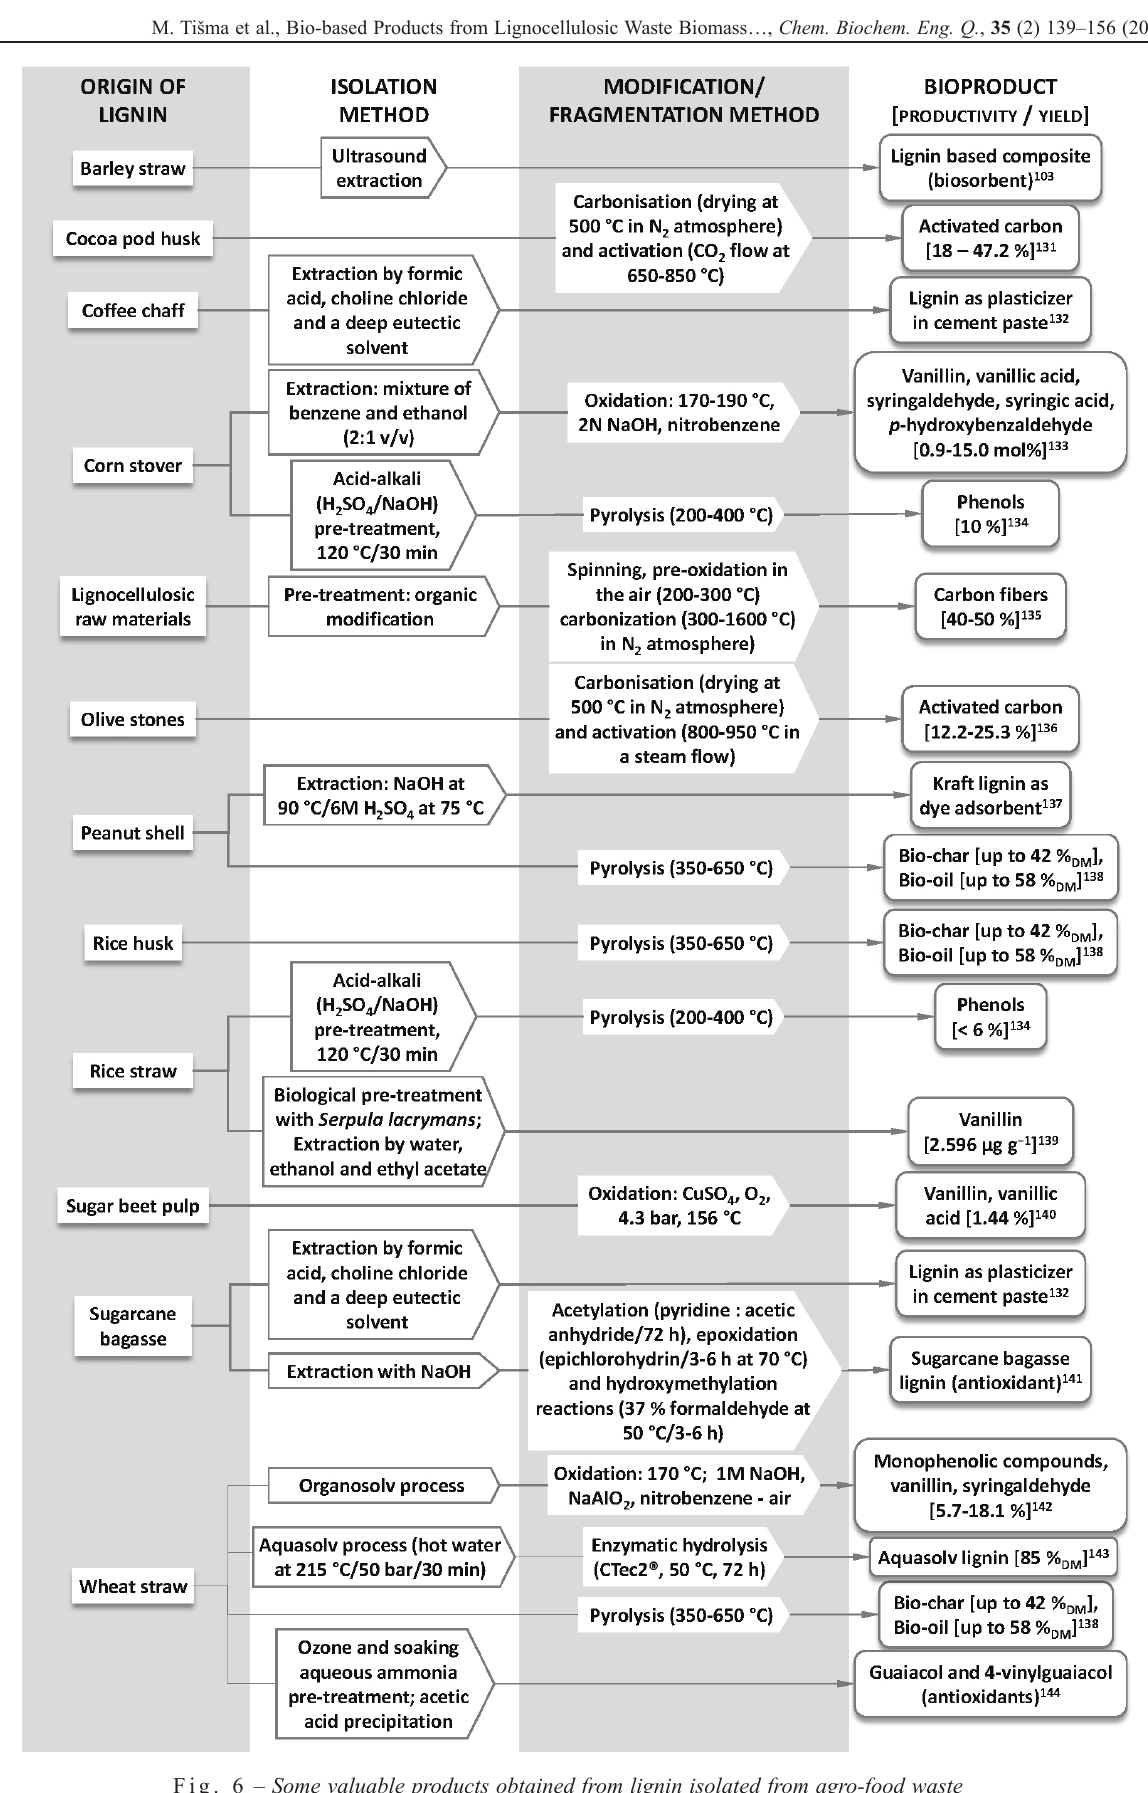
Fig. 6 – Some valuable products obtained from lignin isolated from agro-food